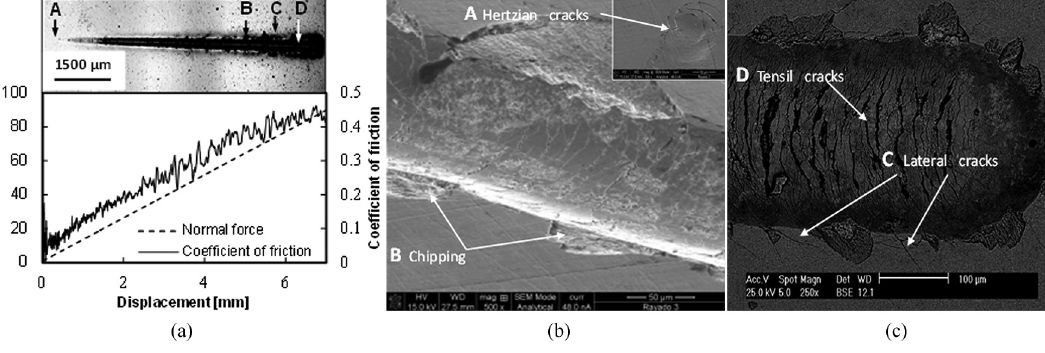
Figure 8. SEM micrographs of scratch test on AISI 304 borided steel at 1223 K during 2 h of exposure time: (a) Correlation between CoF and occurrence of damage, (b) hertzian and chipping mechanism, (c) lateral and tensil cracks.